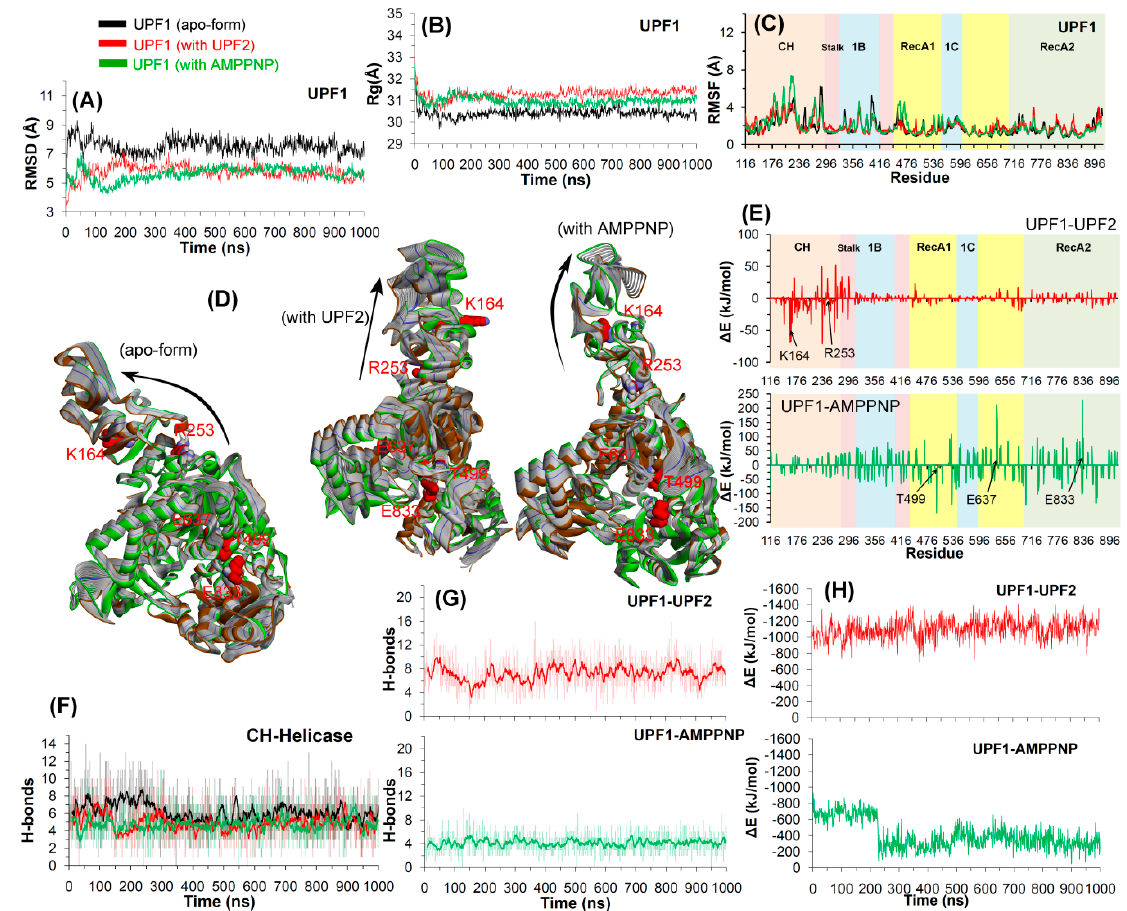
Figure 3. Structural analysis of wild-type UPF1 in the MD simulations. ( A ), ( B ), and ( C ) RMSD, radius of gyration profile, and RMSF representing the structural changes and fluctuations of residues inthe UPF1 protein. ( D ) The protein motion corresponding to the first eigenvector defined on the basis of the combined trajectories (green is from the beginning, blue from 400 ns (where the system stabilized), and brown from the end of the MD). ( E ) and ( H ) Energy contribution of each UPF1 residue to the binding with UPF2/AMPPNP and the total binding energy for UPF1-UPF2/AMPPNP, calculated using MM-PBSA. Contribution of residues selected for mutation analysis are labelled and shown with black arrows in (E). ( F ) and ( G ) Number of hydrogen bonds formed between the CH-helicase domains (intramolecular UPF1) and between UPF1-UPF2/AMPPNP (intermolecular). The dark lines represent the moving average of H-bonds formed with a period of 10 ns (i.e. number of H-bonds averaged every 10 ns). The radius of gyration (R g ) is an indicator of the protein secondary structure compactness. R